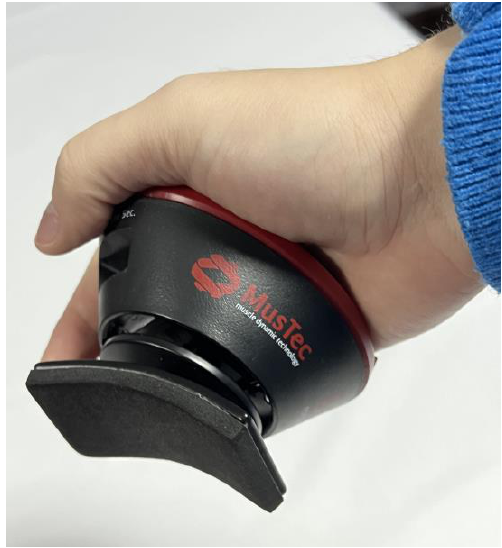
Figure 1. BioFET equipment.